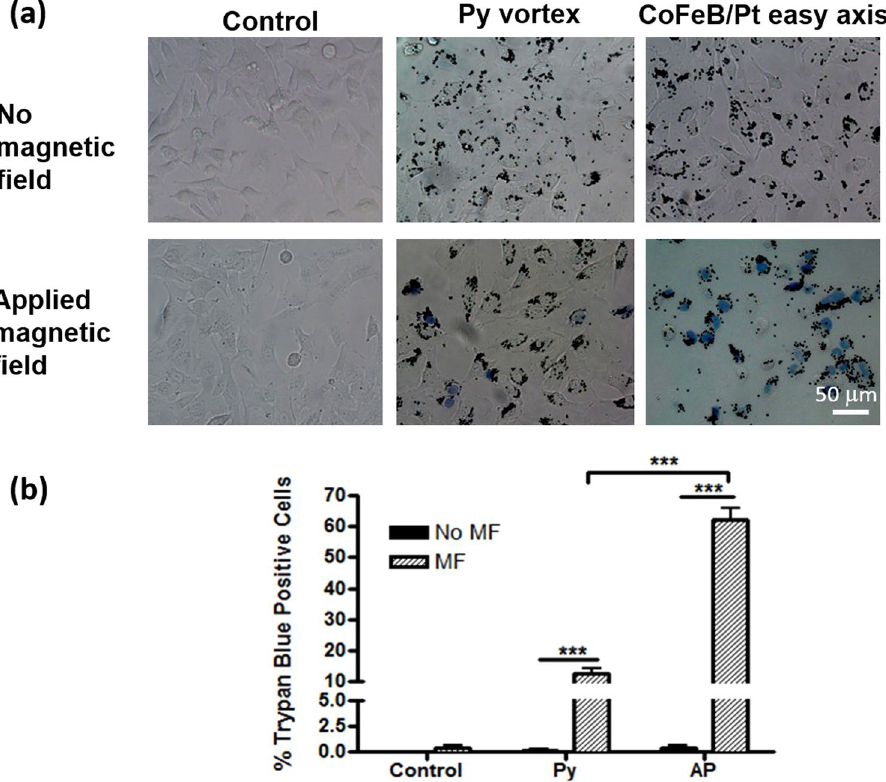
Figure 2. ( a ) Differential interference contrast images of U87 cells after trypan blue staining. U87 cells were incubated with growth media (control), Py particles and AP particles for 24 hours respectively. Cells were then incubated with trypan blue solution (0.2% in PBS) and received magnetic field treatment (MF) for 1 minute. ( b ) Quantification of trypan blue positive cells after 1 minute MF. Data are presented as mean ± standard error (n = 5 images). *** p < 0.001